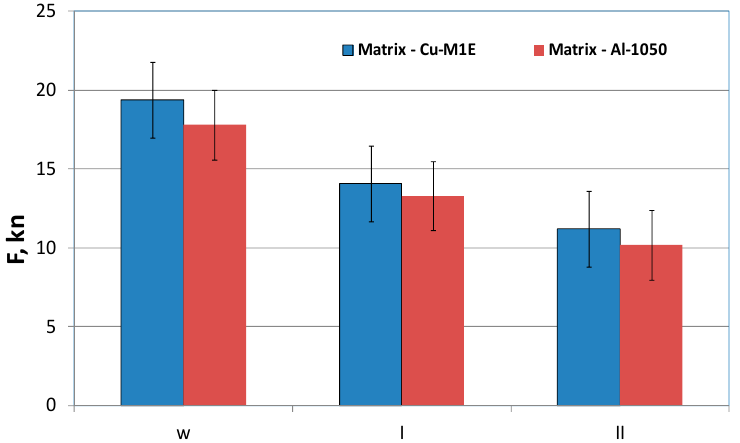
Figure 8. Registered values of maximum forces during the drawing (w) and pressing (I and II) processes .